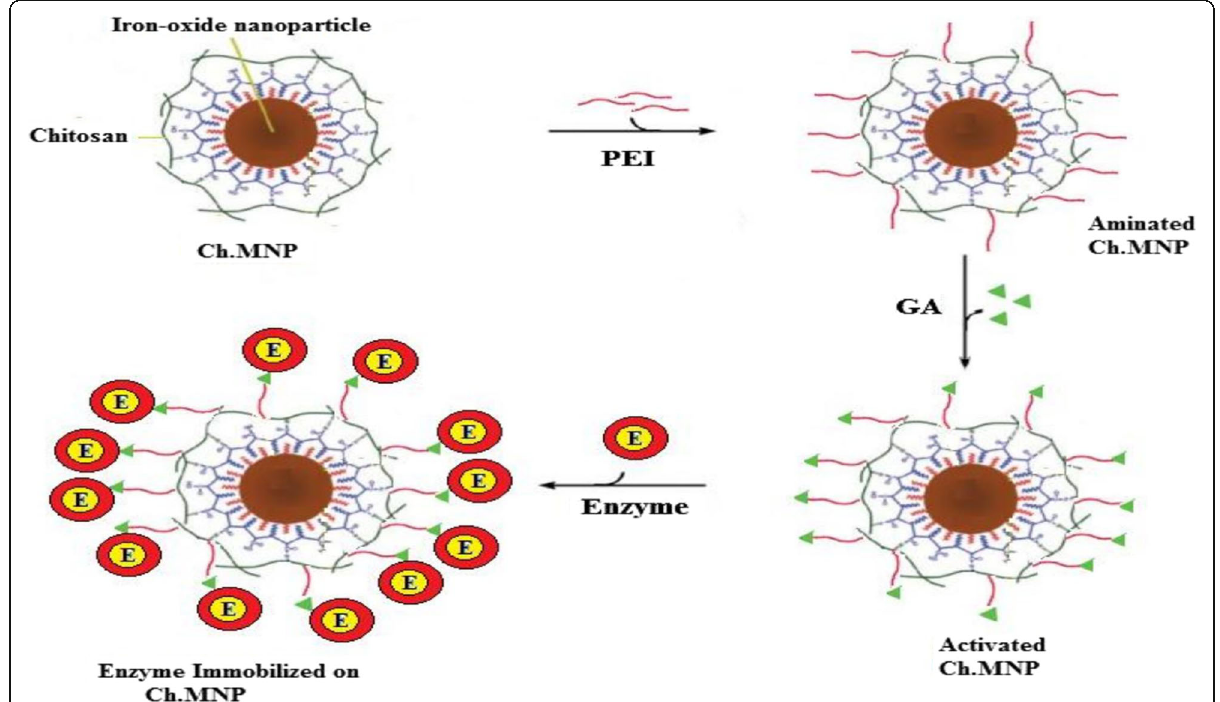
Fig. 3 Mechanism of polymeric gel beads activation and enzyme